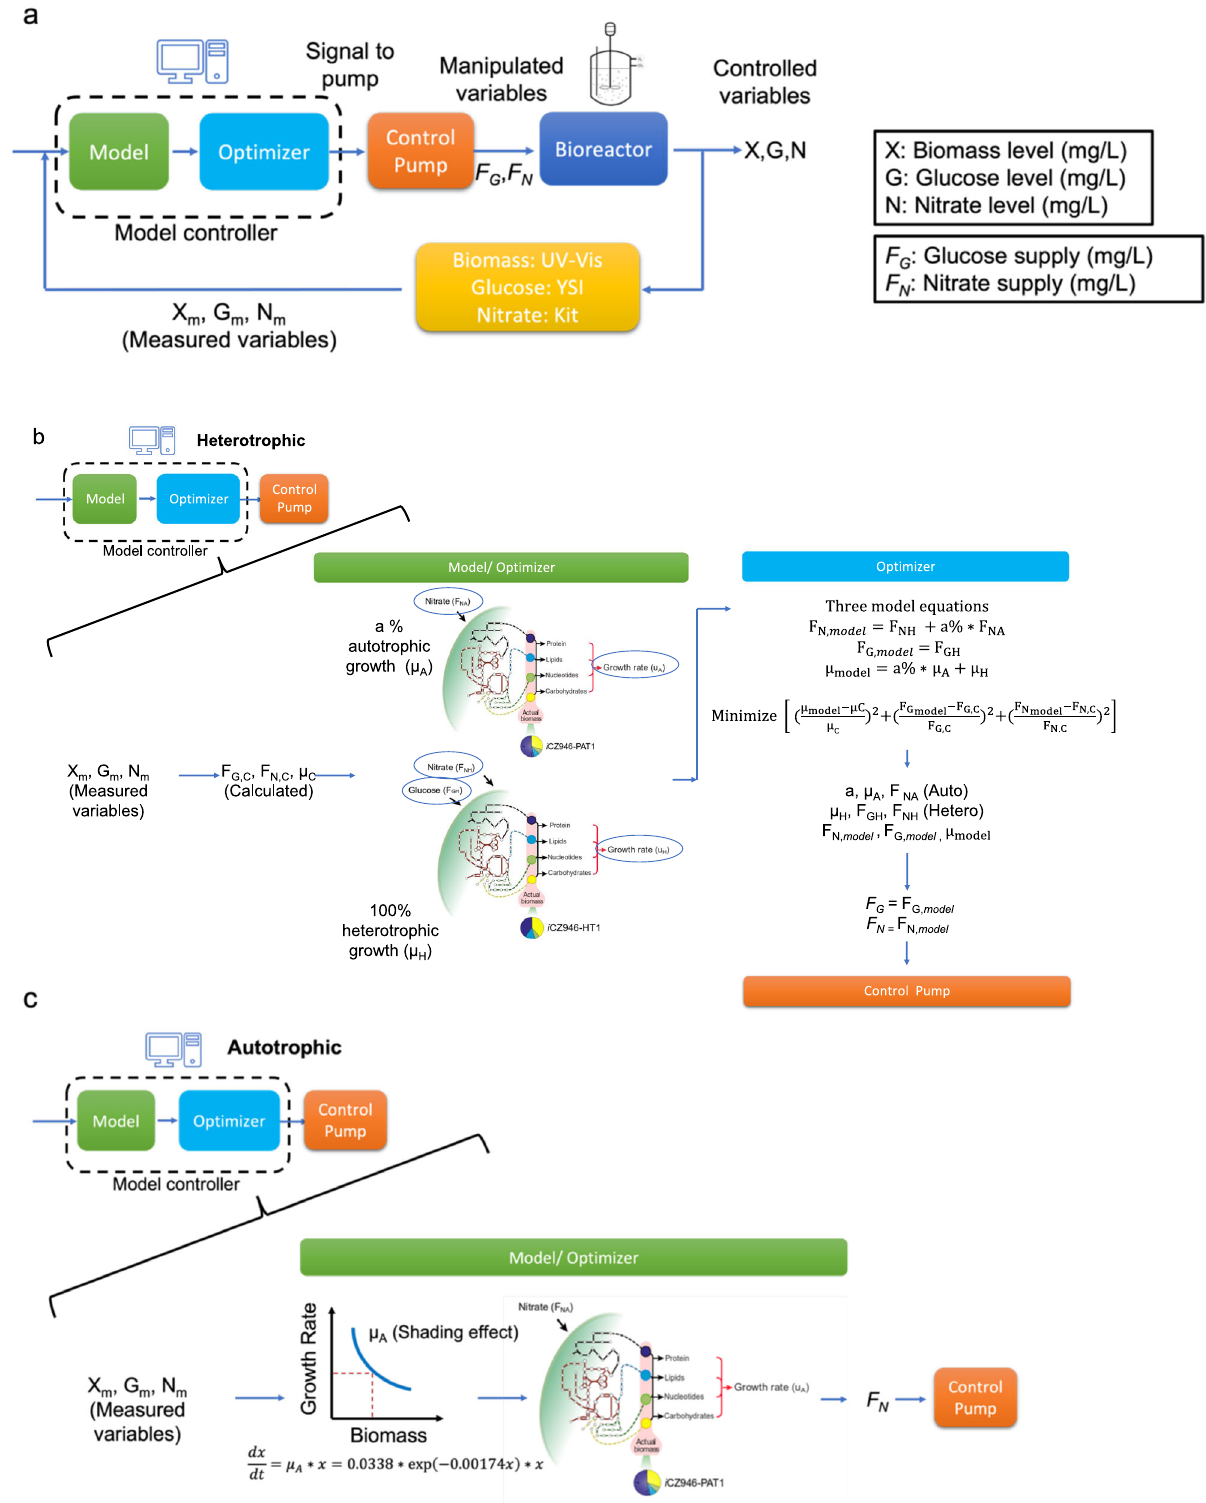
Fig. 3 Closed-loop GMPC. a Flowchart. b Model controller in heterotrophic dark cycles. c Model controller in autotrophic light determined based on measured inputs (X m , G m , N m ). Next, the heterotrophic (dark) conditions based on the algorithm shown in model and algorithm optimizer (green and blue boxes in Fig. 3b) Fig. 3b. The algal cells were assumed to operate under two then estimate the fractions of photoautotrophic growth and different types of metabolism in the simulations for the dark cycle. heterotrophic growth in order to determine the feed under One fraction of algal cells was assumed to grow strictly